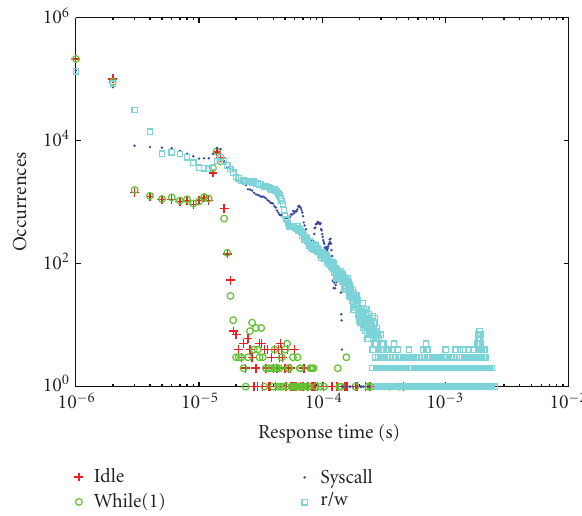
Figure 3: Idle versus processor load (test 2) versus syscall load (test 3) versus read/write load (test 4).